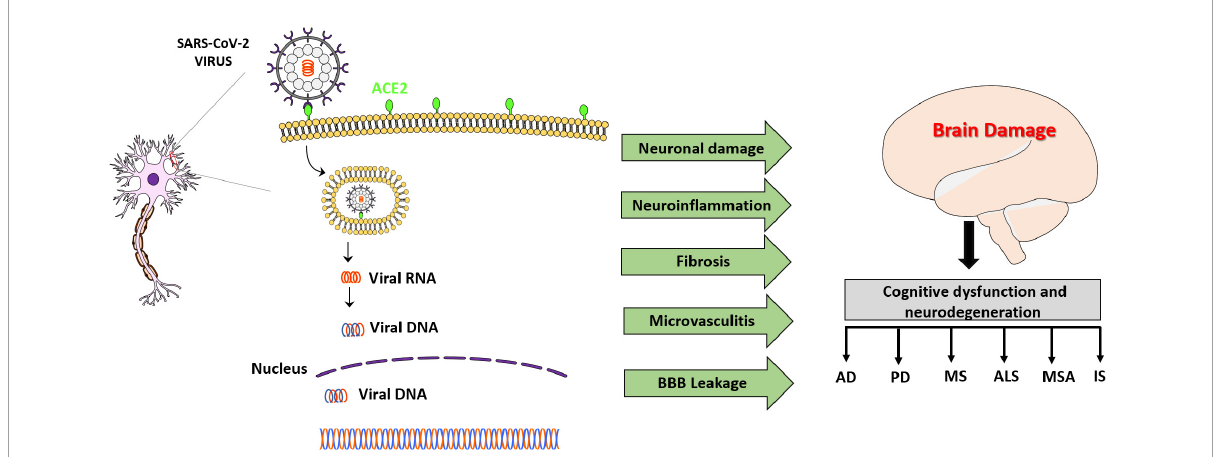
FIGURE2 Schematic representation showing the neuronal infection of SARS-CoV-2 virus and CNS damage caused by the infection that leads to cognitive dysfunction and neurodegenerative diseases. Angiotensin-converting enzyme-2 (ACE-2), Alzheimer’s disease (AD), Parkinson’s disease (PD), Multiple sclerosis (MS), Amyotrophic lateral sclerosis (ALS), Multiple system atrophy (MSA), Ischemia stroke